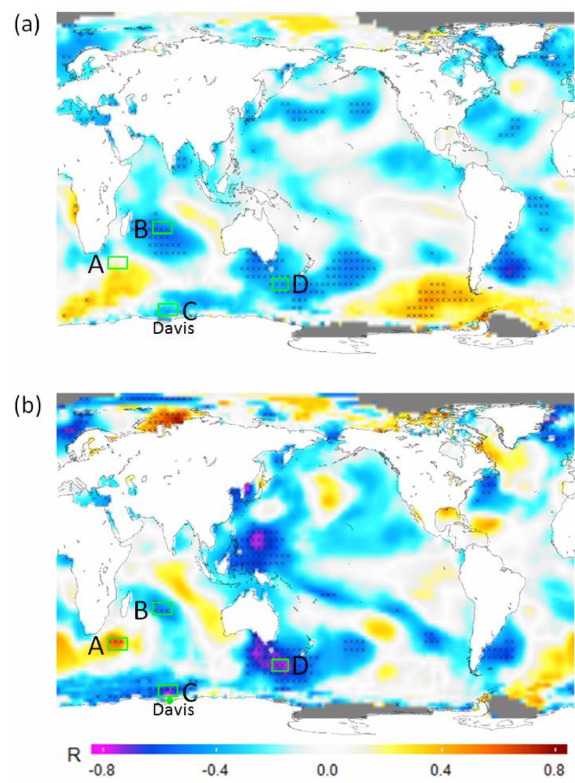
Figure 5. Correlation maps of the Davis OH residual (24-year) QQO signal (a) and MLS 0.0046hPa (AMJJAS) polar cap aver- age residual (14-year) QQO signal (b) with the Extended Recon- structed Sea Surface Temperature (AMJJAS) average anomalies. Cross-hatched points are significant at the 90% level (every second grid point marked). Grey areas are permanent sea